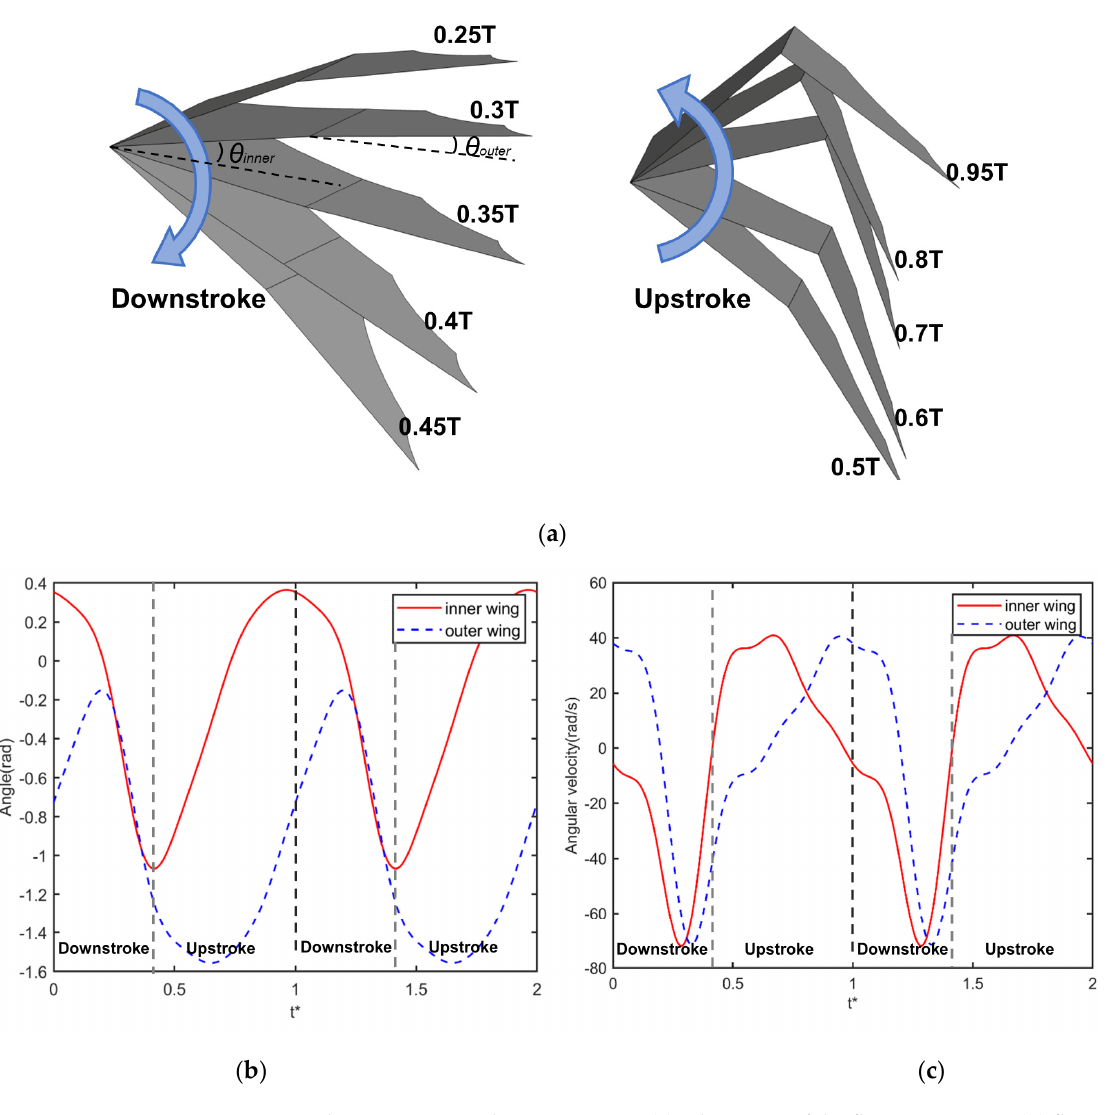
Figure 3. Flapping motion characterization: ( a ) schematics of the flapping motion; ( b ) flapping angles in two flapping cycles; ( c ) angular velocity in two flapping cycles.